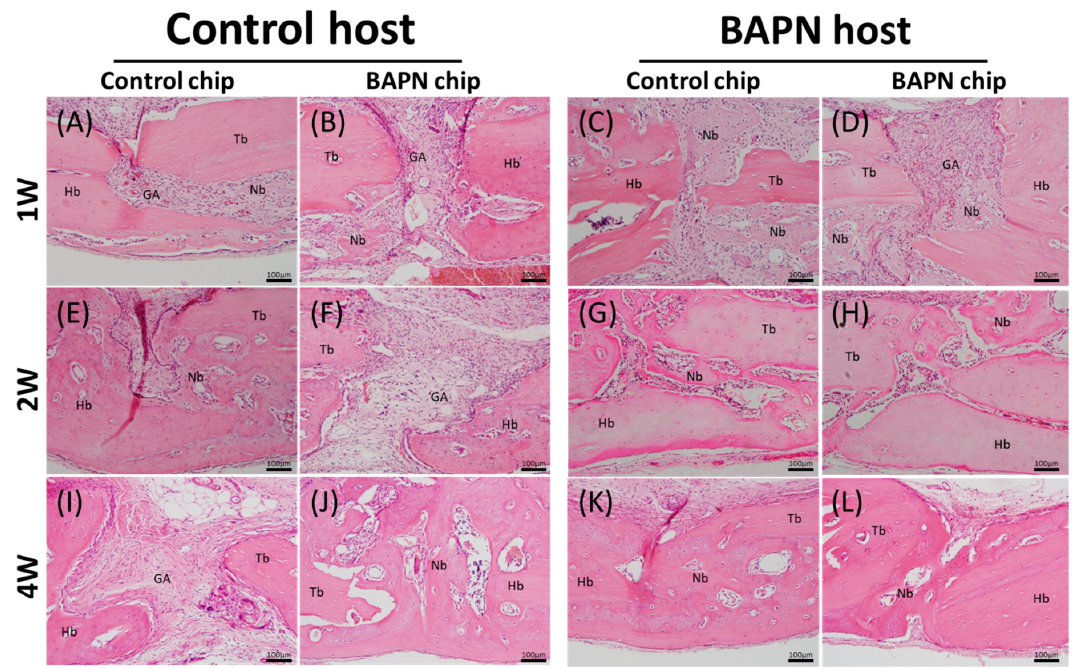
Table 1 Percentage of bone union formation by bone tissue bridges between transplanted bone and host bone. Each number represents the percentage of positive (i.e., union) sections out of all sections investigated. Regardless of transferred bone condition, control hosts versus BAPN host had 75 and 100% respectively of bone bridging (i.e., unions). The non-union of control and BAPN host was 25 to 0% respectively.